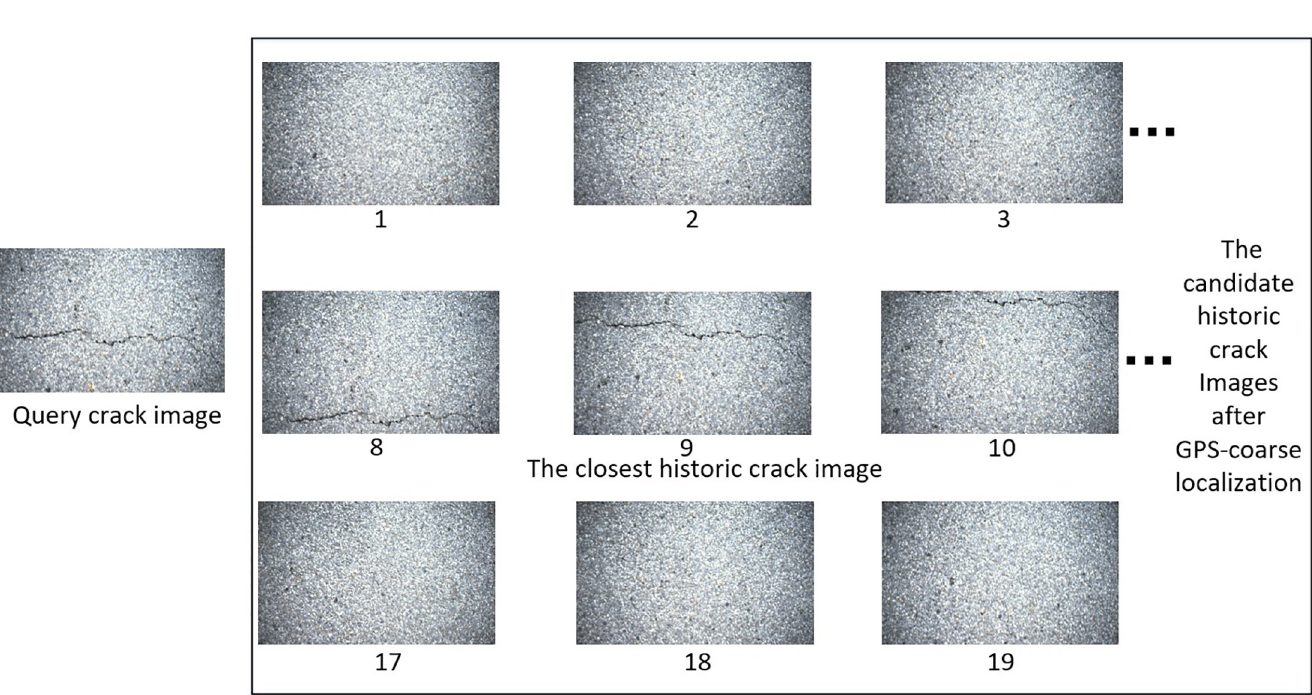
Fig 8. The results for GPS-based coarse localization. The image-level localization by matching local feature points and the number of matched feature point pairs for different historical images are